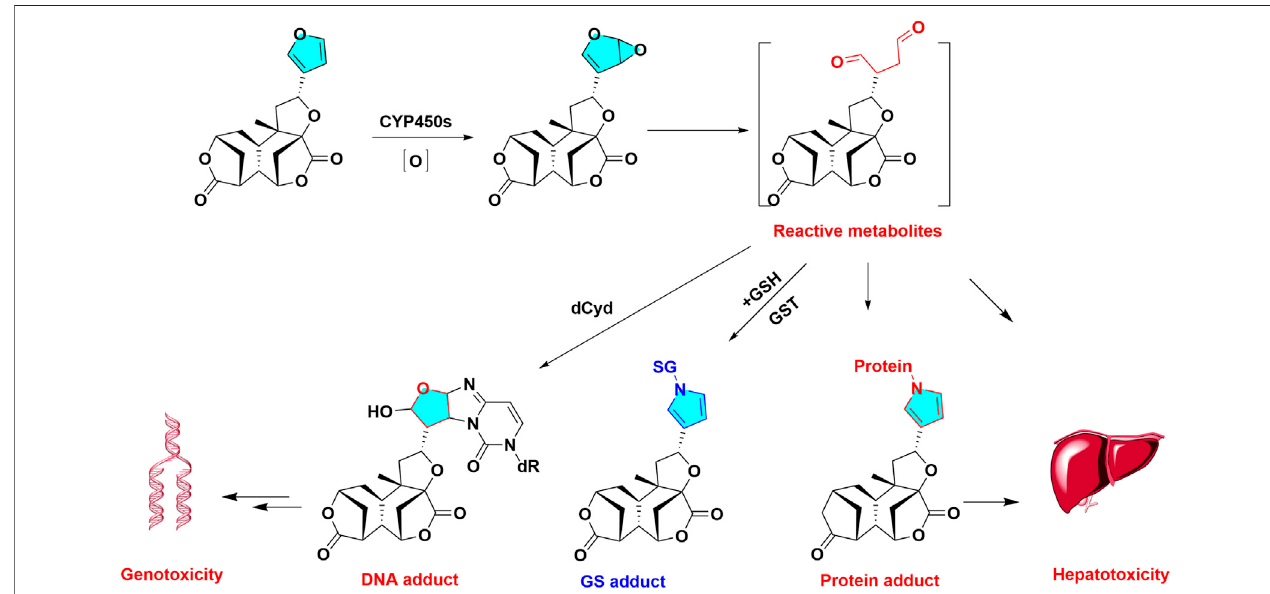
FIGURE 2 | Metabolic activation diosbulbin B induced hepatotoxicity. Diosbulbin B is epioxidized and hydrolyzed to reactive metabolites of cis-Enedial, reactive metabolites can capture GSH, protein, DNA, forming GSH, protein, DNA adduct, respectively.